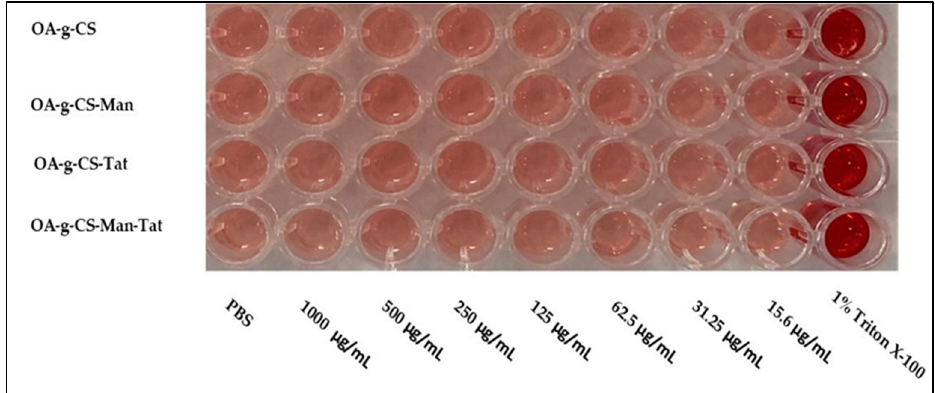
Figure 6. Images of hemolysis caused following 1 h incubation with different polymers at different concentrations.